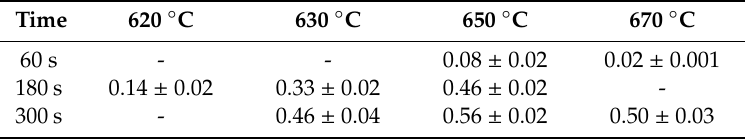
Table 1. The fraction of ferrite as a function of holding temperature and time.